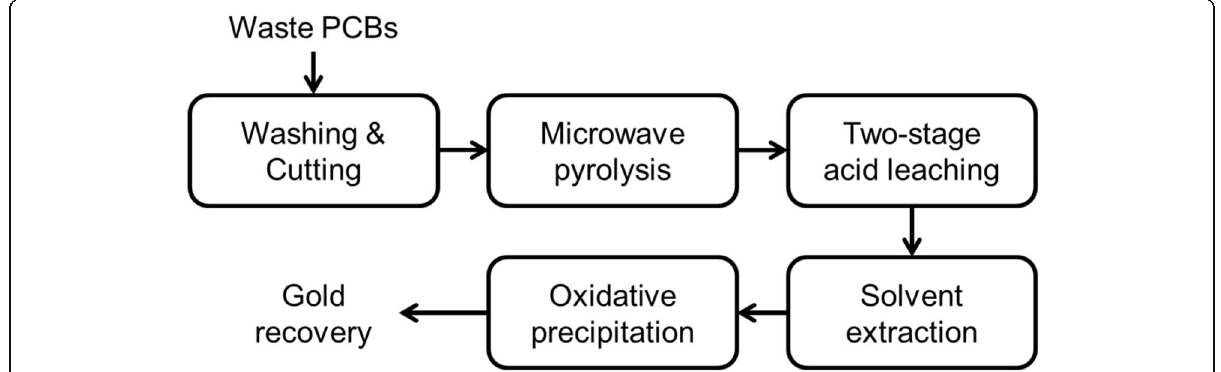
Fig. 1 Experimental procedures of gold recovery from waste